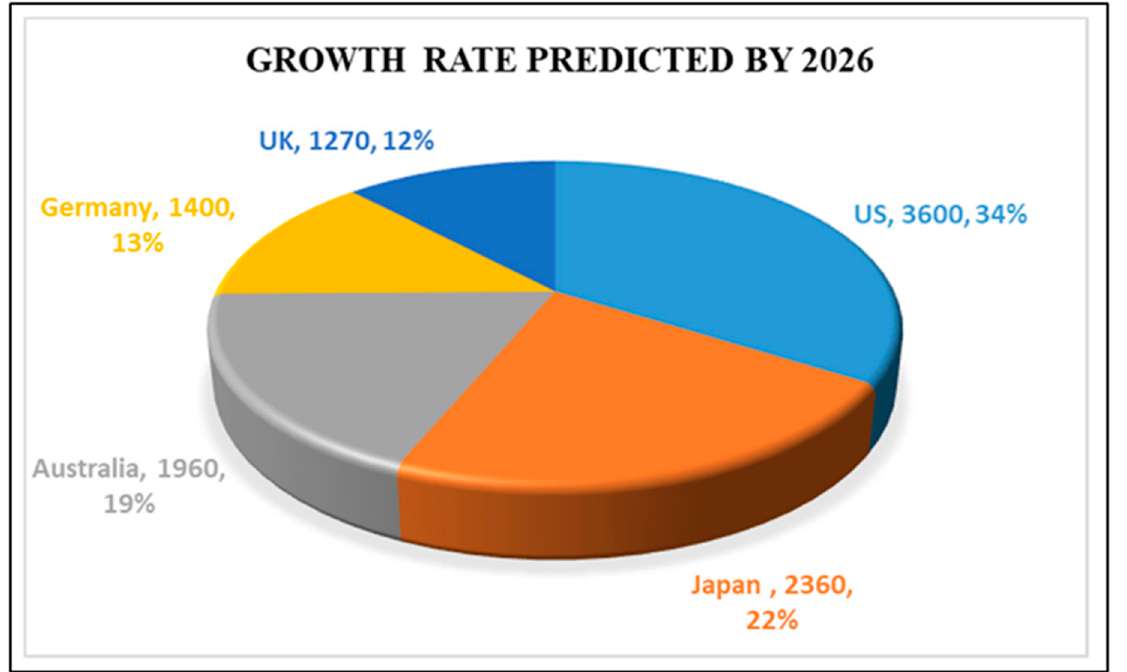
Figure 3. Future of global markets for active packaging by the year 2026 Reprinted with permission from ref [16].